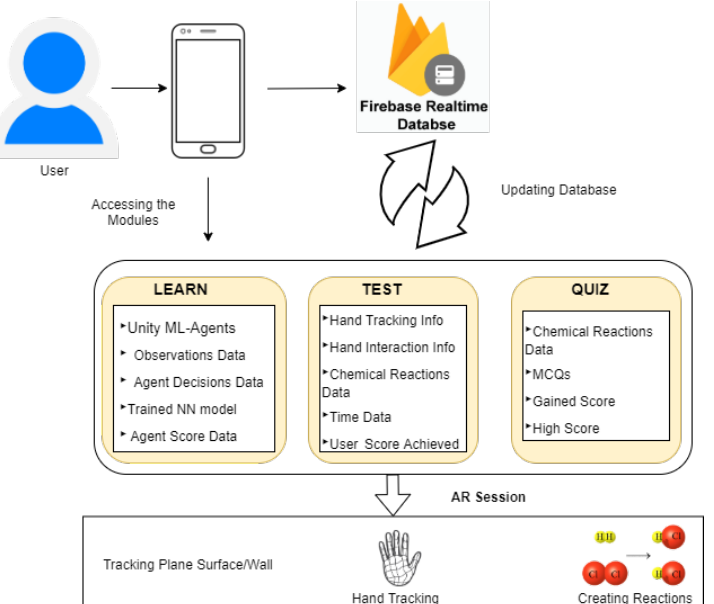
Figure 11. Architecture diagram and working flow of recommended approach in second case study.